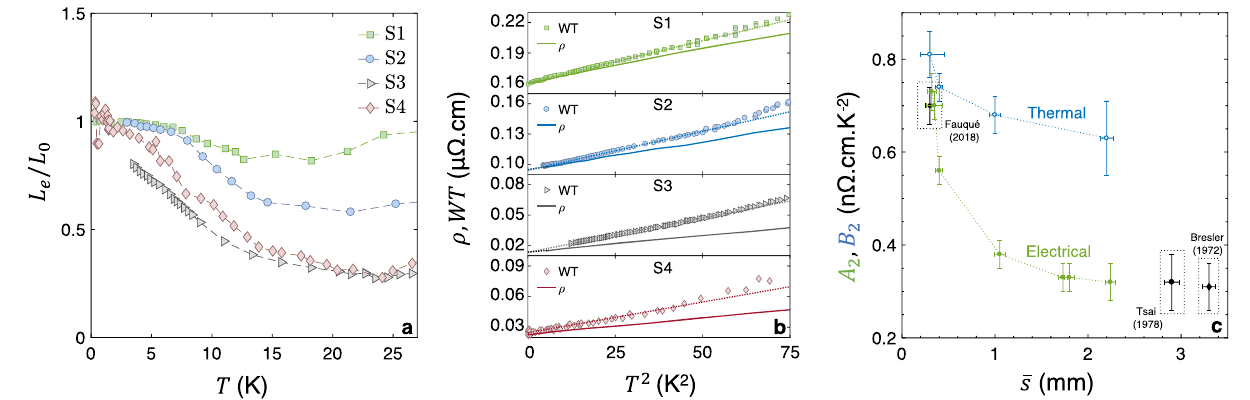
Fig. 5 The WF law, the T -square resistivities, and their evolution with disorder. a Electronic fraction of the Lorenz number L e = κ e ρ / T plotted as L e / L 0 , where L 0 is the Sommerfeld number, as a function of temperature. L e / L 0 = 1 corresponds to the recovery of the Wiedemann-Franz law. b Thermal ( WT ) and electrical ( ρ ) resistivities plotted as functions of T 2 for the four sizes of Sb samples. WT is featured as symbols while ρ is shown as a solid line. All four graphs share a common x-axis and y-axis span. c Evolution of the electrical and thermal T 2 -resistivities prefactors with sample size in Sb. Data points from 23,32,33 are featured. Error-bars along the x-axis are de fi ned by the uncertainty on the geometry of the samples while they are de fi ned along the y-axis by the standard deviation of the T 2 - fi t to the resistivity